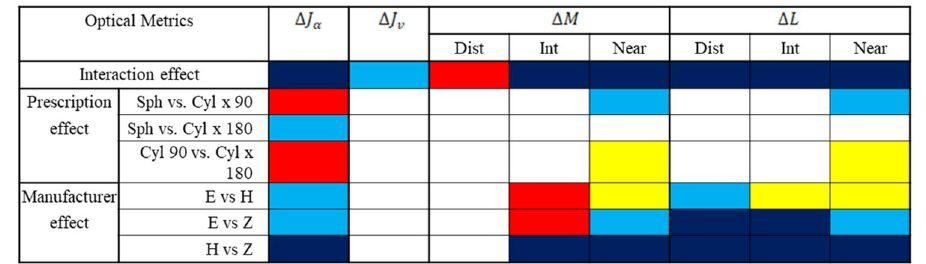
0.05; yellow, p 0.01; red, p ≤ ≤